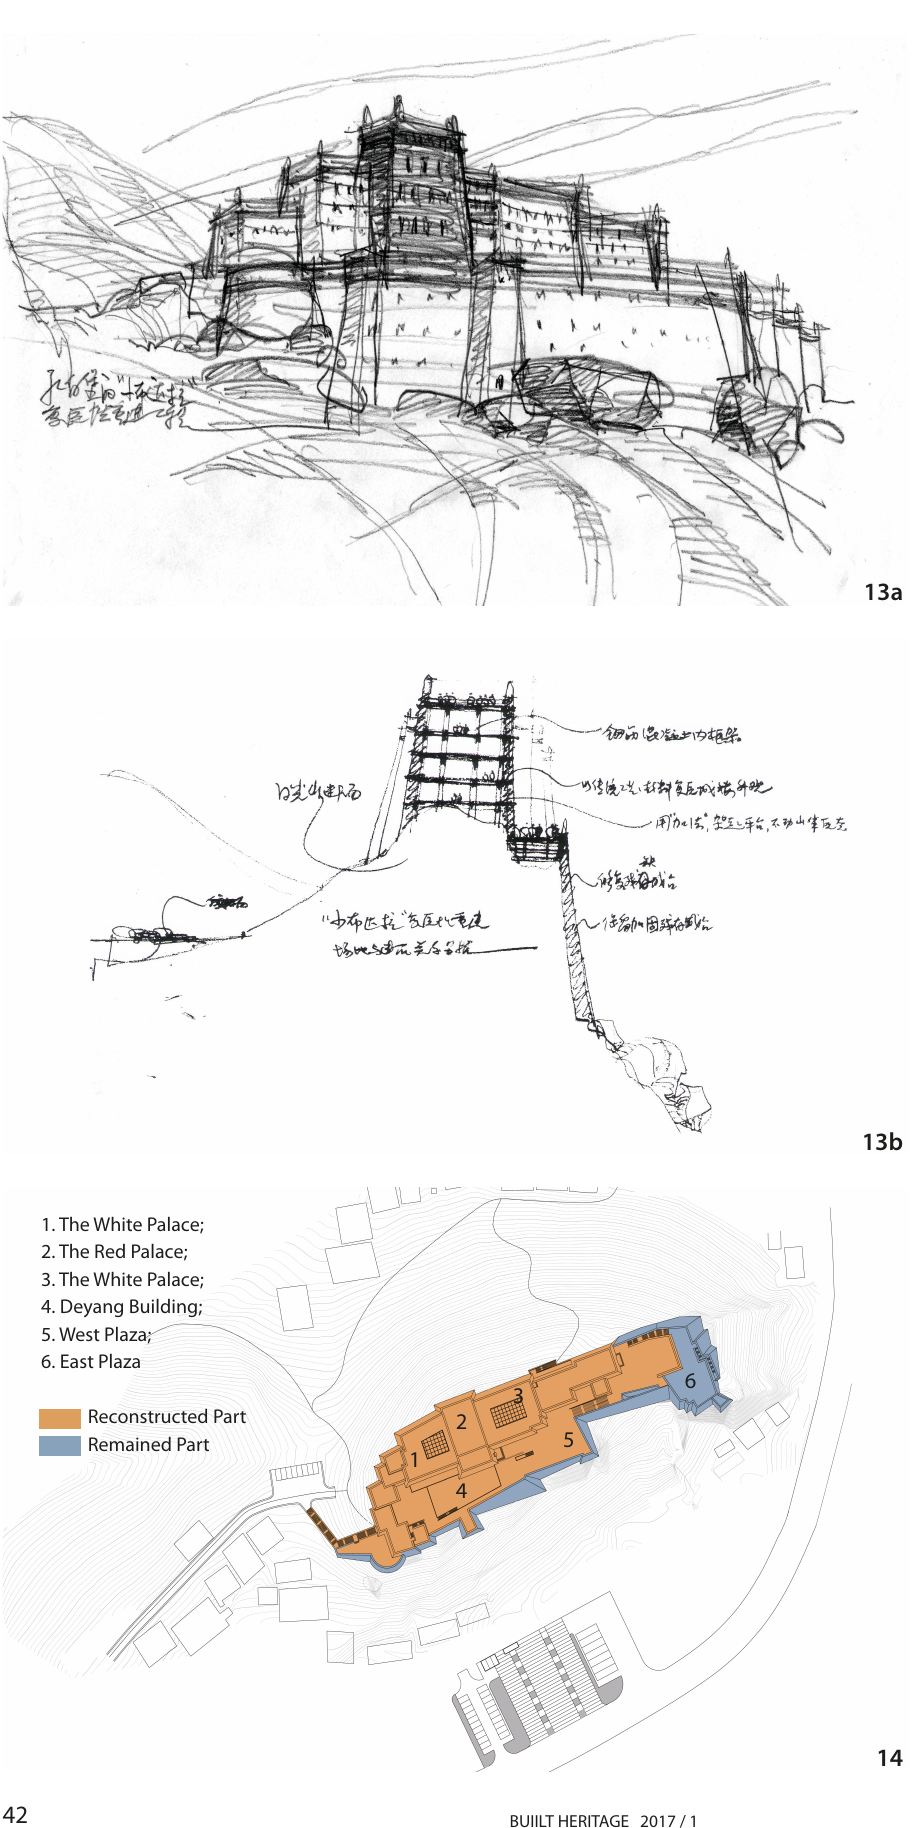
Figure 13a Sketch of restoration concept for the Sangzhutse For- tress (Drawn by the author). Figure 13b Section of Sangzhutse Fortress (Drawn by the author). Figure 14 The plan of the Sang- zhutse Fortress after restoration (Source: Chang Qing